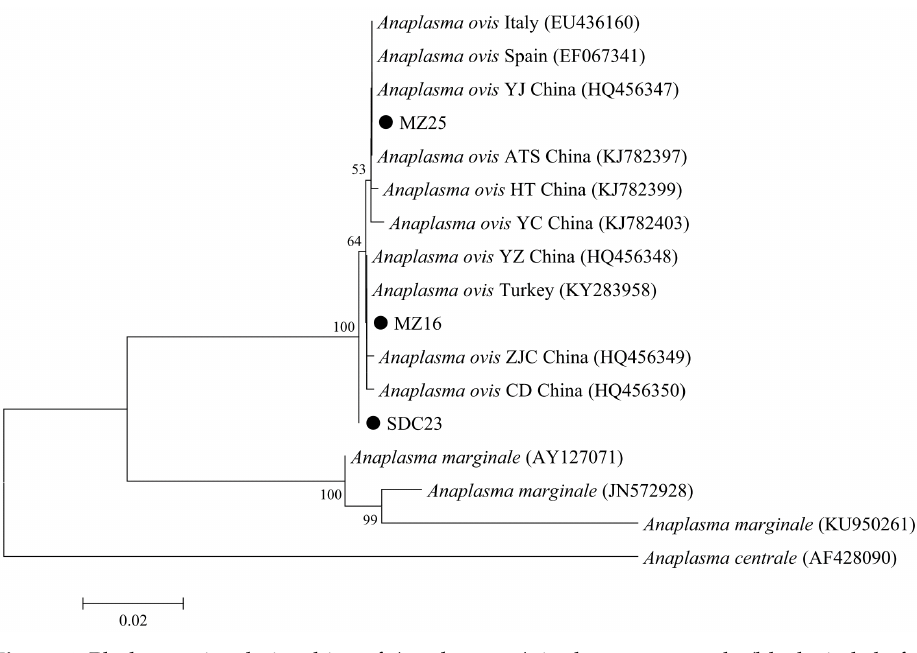
Figure 4. Phylogenetic relationships of Anaplasma ovis in the present study (black circle before the sample name) with reference sequences from GenBank TM based on the sequence analysis of the msp4 gene by neighbor-joining analysis using the Kimura 2-parameter model. Bootstrap values (>50) are indicated at the nodes. Scale bar indicates 0.02 nucleotide substitutions/site. Anaplasma centrale (AF428090) is used as the outgroup.